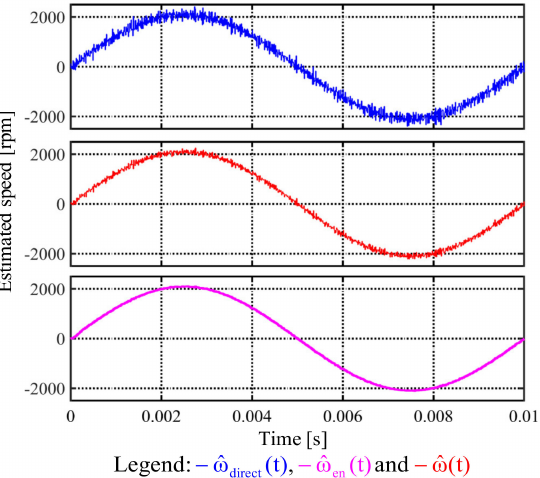
Figure 11. Simulation of different speed estimations under a sinusoidal position feedback signal (0.002% white position